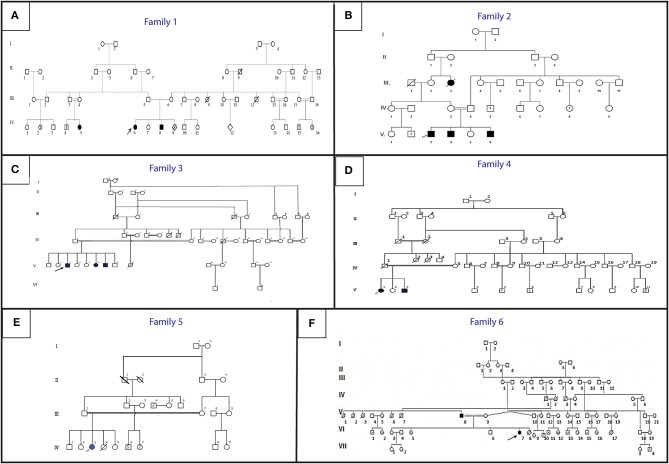
Pedigree describing affected HGPPS family's members. Filled symbols represent affected individuals, open symbols represent unaffected individuals. The probands are indicated with an arrow. (A) Family 1, (B) Family 2, (C) Family 3, (D) Family 4, (E) Family 5, (F) Family 6.